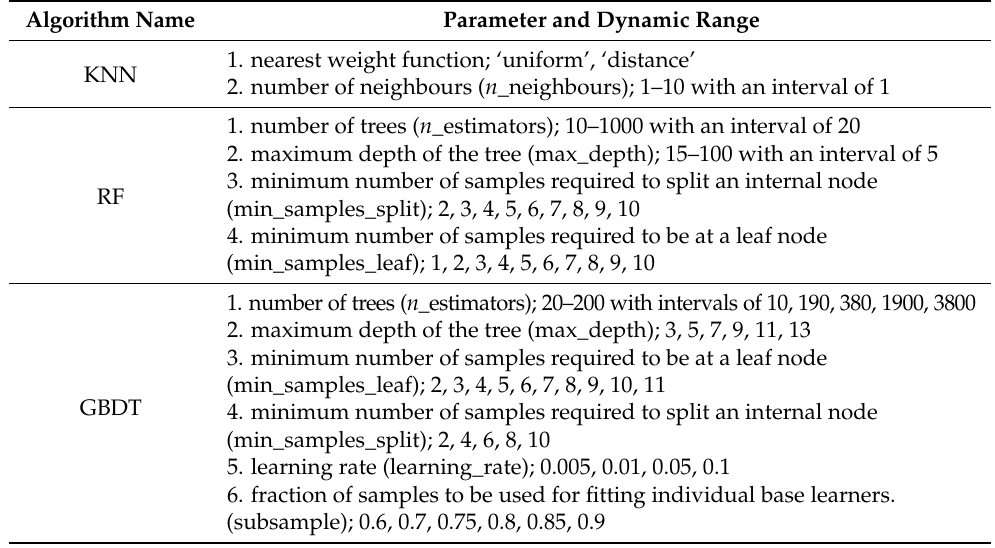
Table 4. Adjustment parameters and dynamic ranges of different ML algorithms.